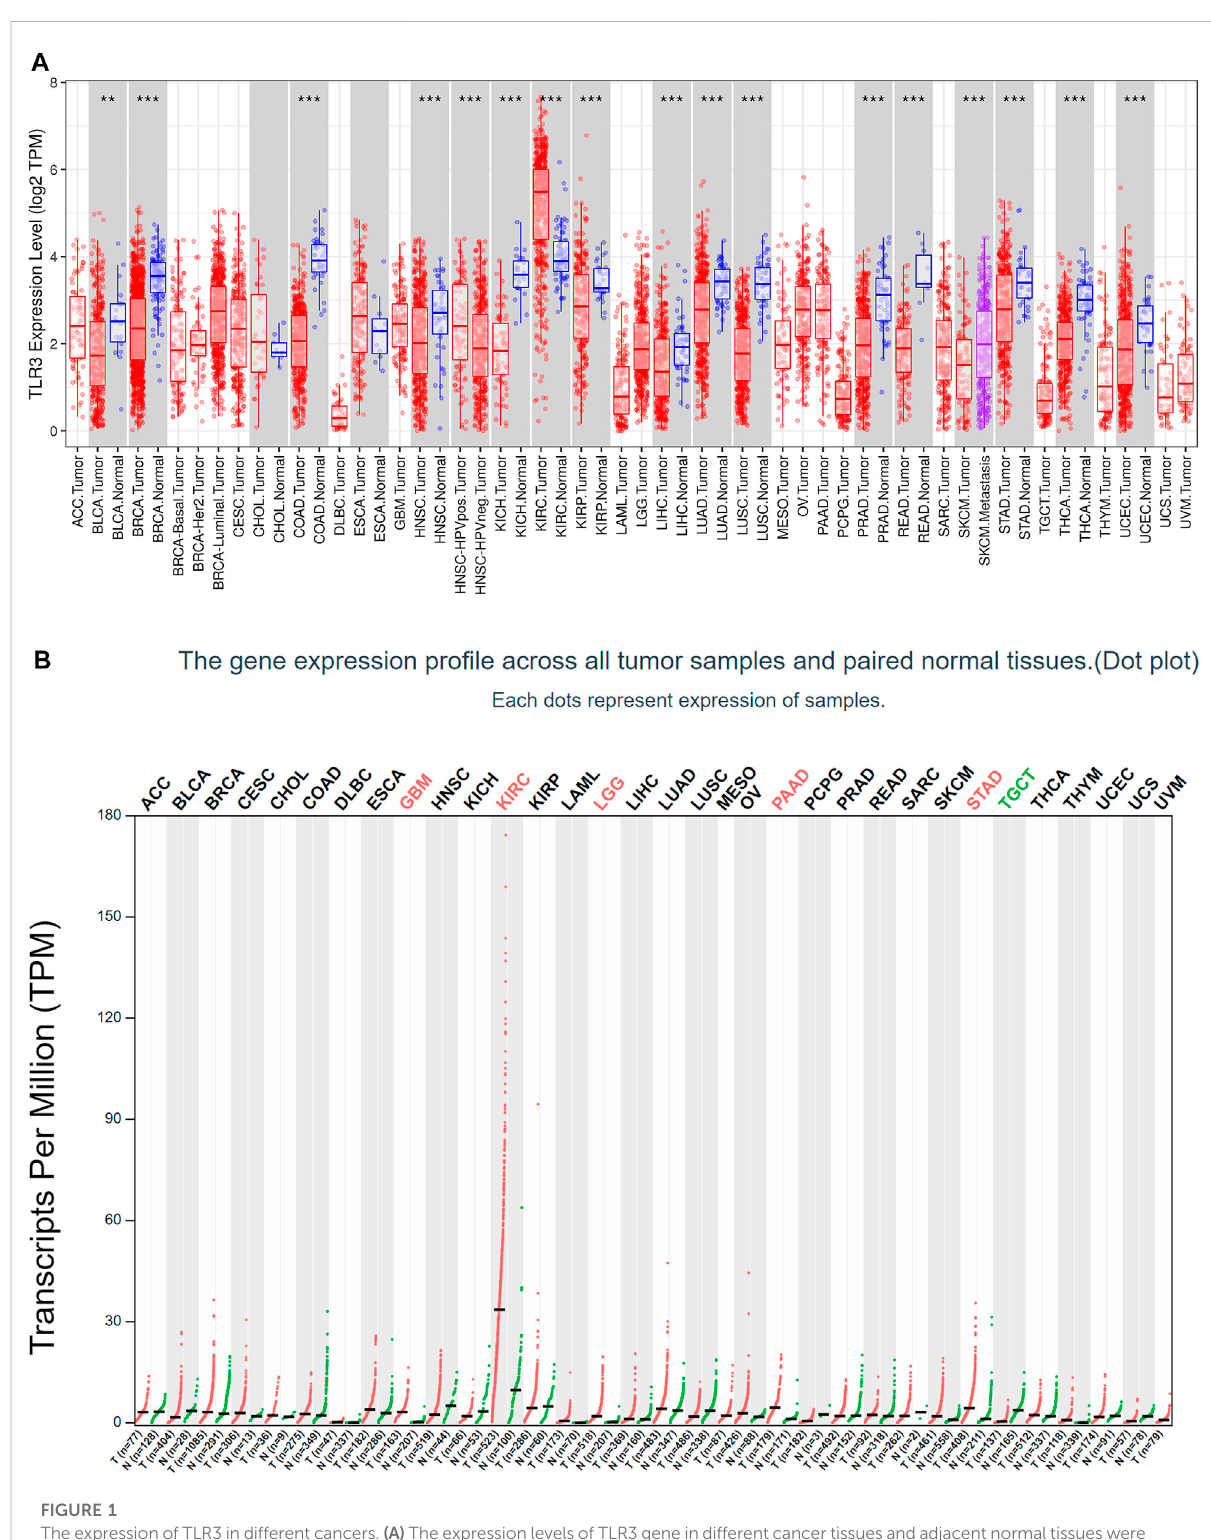
FIGURE 1 The expressionofTLR3 in different cancers. (A) The expressionlevels of TLR3 gene indifferentcancer tissues and adjacentnormal tissues were obtainedbyTIMER. (B) ExpressionlevelsofTLR3transcriptobtainedfromGEPIAindifferentcancertissuesandpairednormaltissues.* p < 0.05;** p < 0.01; *** p <